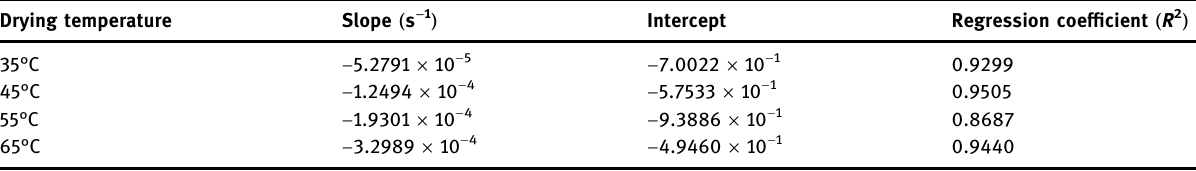
Table 1: Parameters obtained for the linearization of the function ln ( MR ) = f ( t ) , for the di ff erent temperatures tested Drying temperature